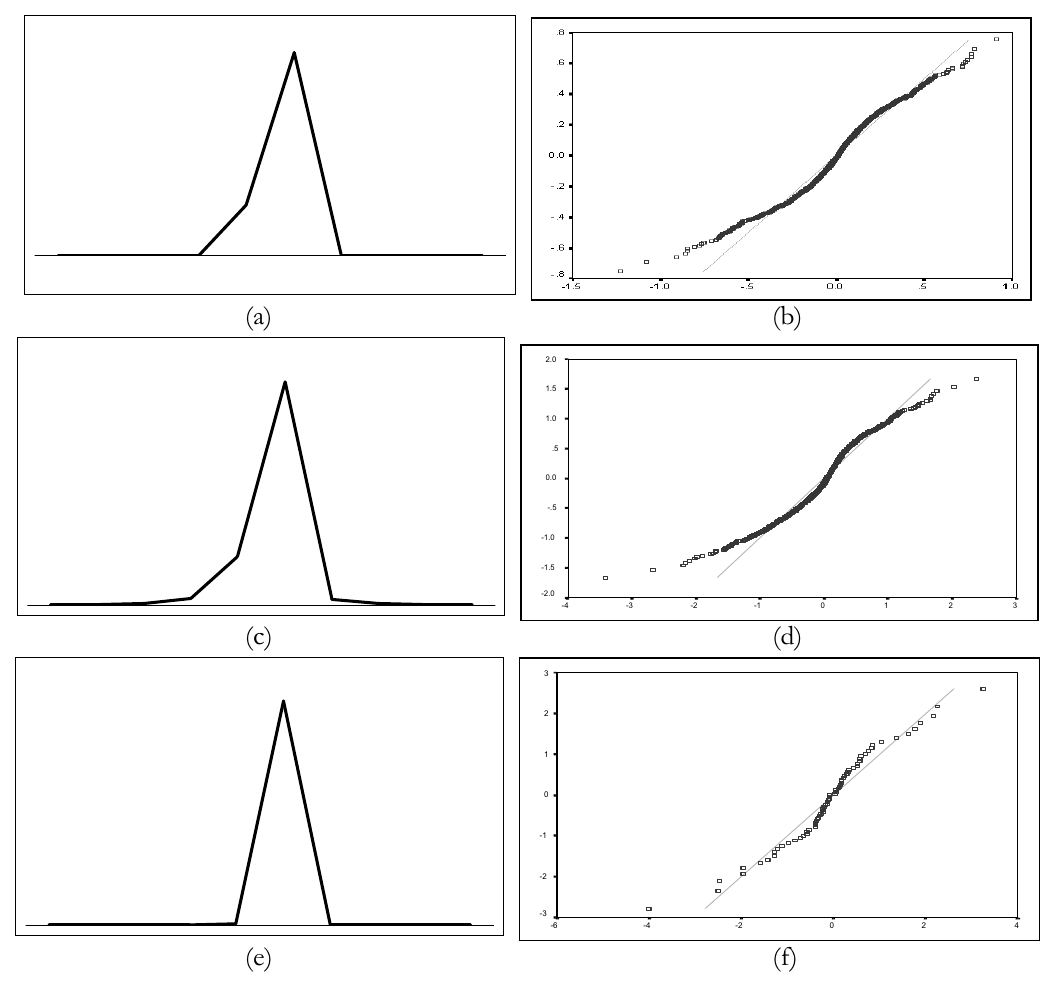
Figure 5 – Continuous approximations of the histograms and QQ plots of the residuals, given state one (a; b), two (c; d) and three (e;